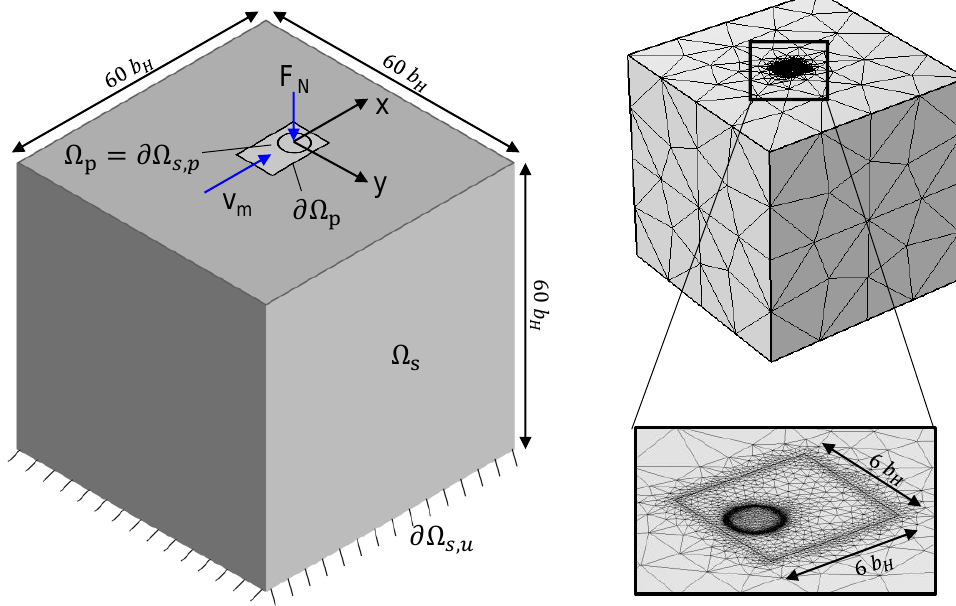
Figure 3. Domain (left) and mesh (right) of the FE isothermal EHL model. Equations (5), (7), and (8) are discretized separately using the finite element method and coupled through equation (6). Streamline-Upwind Petrov-Galerkin [33] and Galerkin- Least-squares stabilizations [34] are applied to the Reynolds equation (5). COMSOL Mul- tiphysics solves the fully-coupled discretized system of equations in a Newton-Raphson scheme with MUMPS linear solver [35].